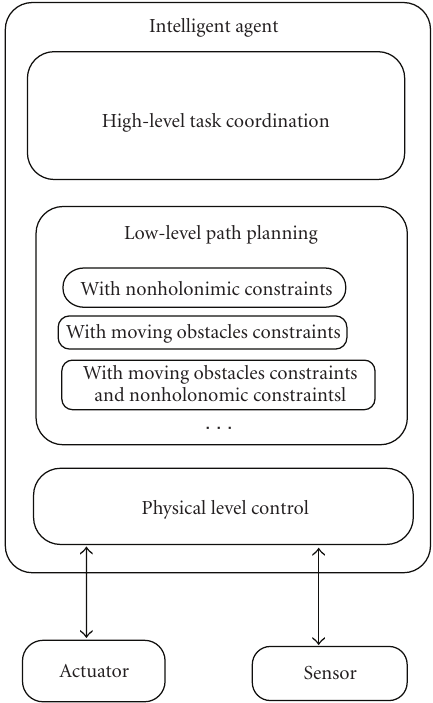
Figure 1: Agent-based navigation software architecture. The archi- tecture of a single agent is structured in four hierarchical layers: DecisionMaking (DM) , KnowledgeBase (KBase) , Interaction and Communication . Local and remote sensor information is integrated into the knowledge base, and no distinction is made between them during motion